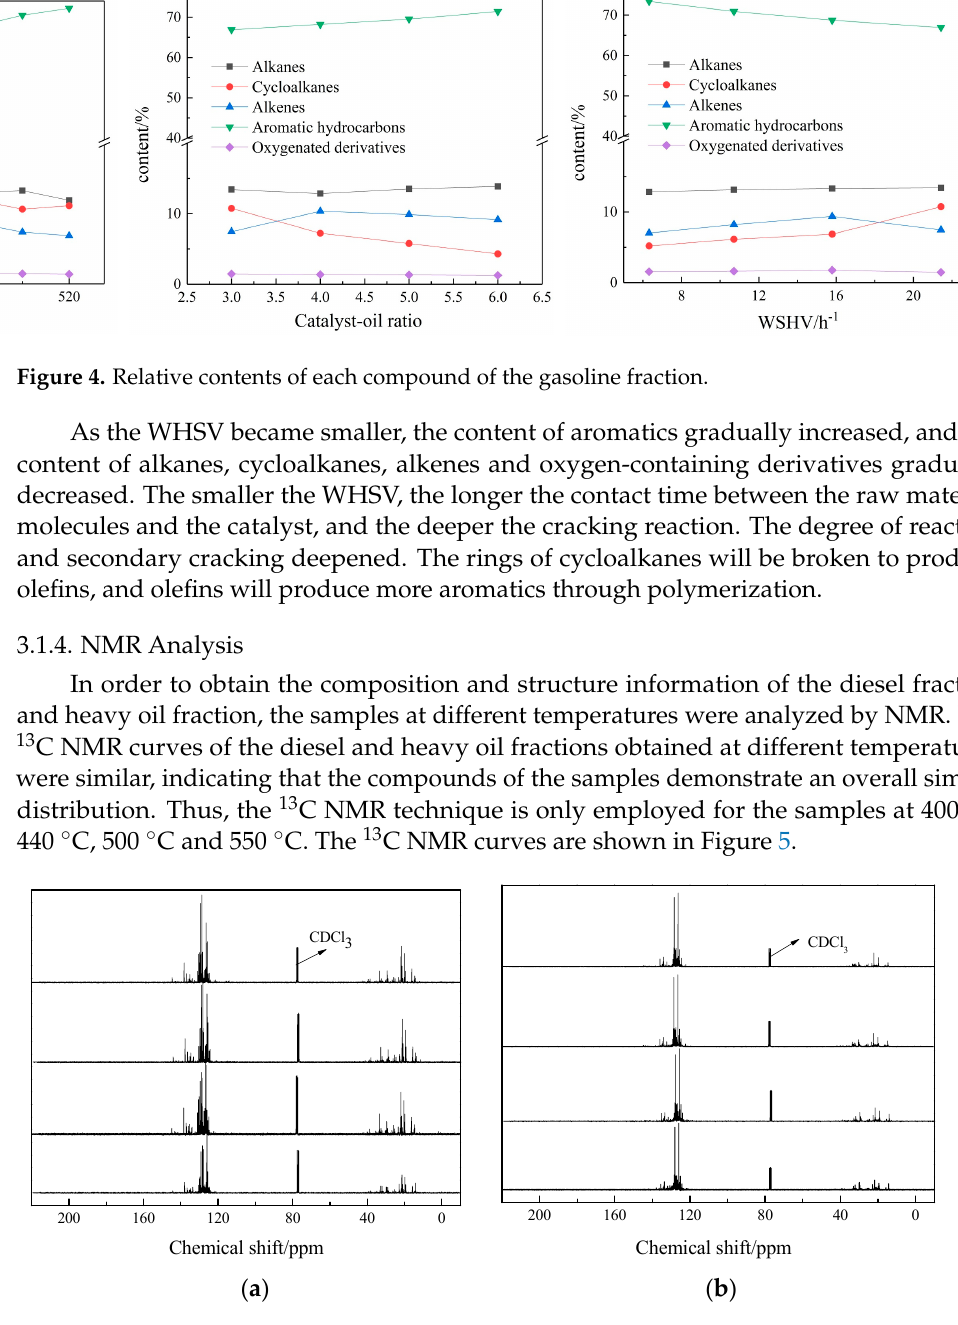
Table 1. 13 C NMR analysis results of different samples. Chemical Shift